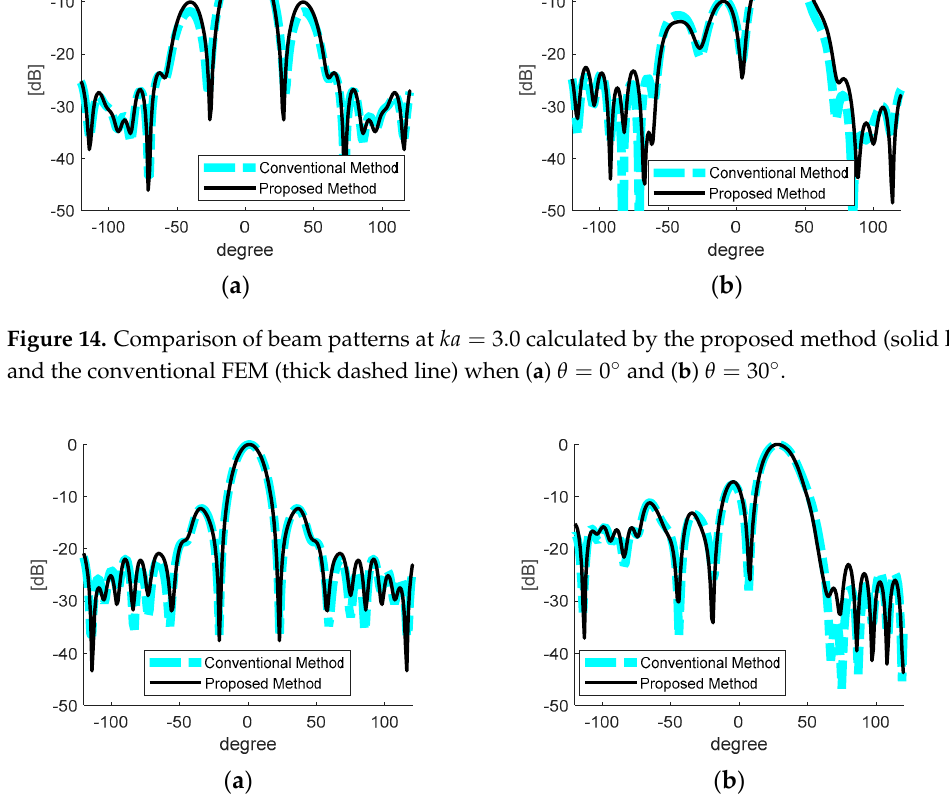
= = calculated by the proposed method (solid calculated by the proposed method (solid =  θ = =  θ =  θ = and ( b ) 30 . and ( b ) 30 . calculated by the proposed method (solid =  θ =  θ and ( b ) 30 .